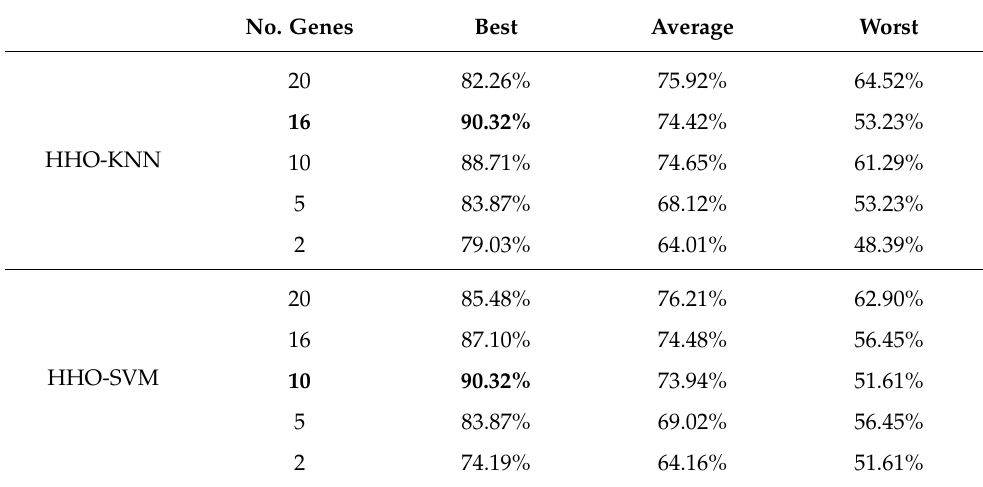
Table 3. Colon data set results.